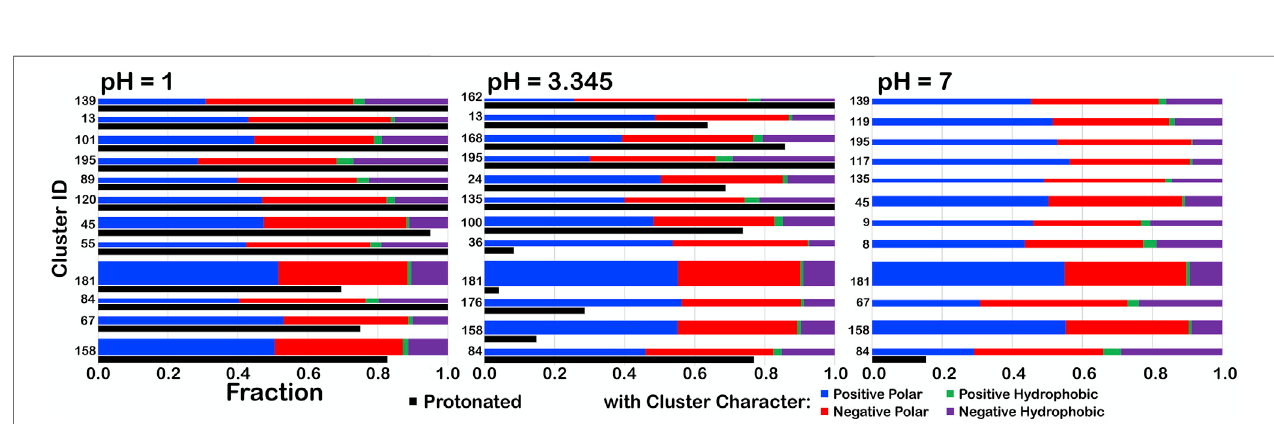
FIGURE13| CharacterinteractionchartsforASPresiduesintheb1.300parseatpH1,3.345,and7.Thefractionofeachinteractiontypeisgivenonthex-axis,for each cluster ID on the y-axis. The bars are arranged such that, descending, clusters have smaller SASAs. The thickness of the bars indicates residue population contained within that cluster. The black bars indicate f prot , the fraction of the residues in the cluster protonated.